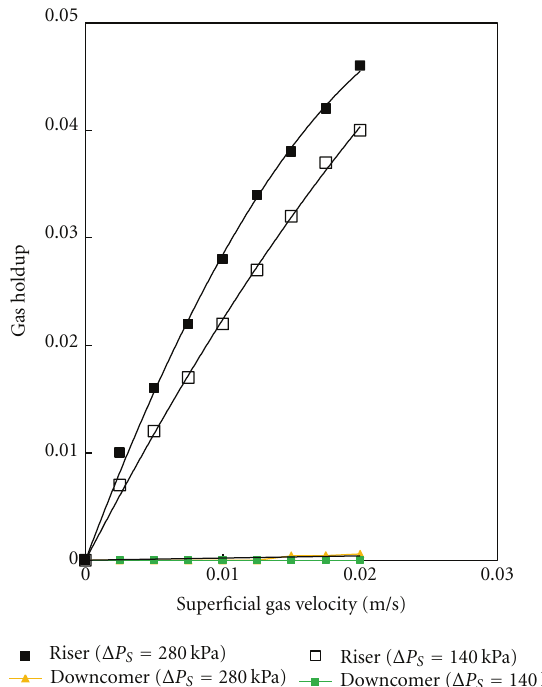
Figure 9: E ff ect of coalescence retardation gas holdup in the riser (transonic sparger, Δ P S = 280kPa).